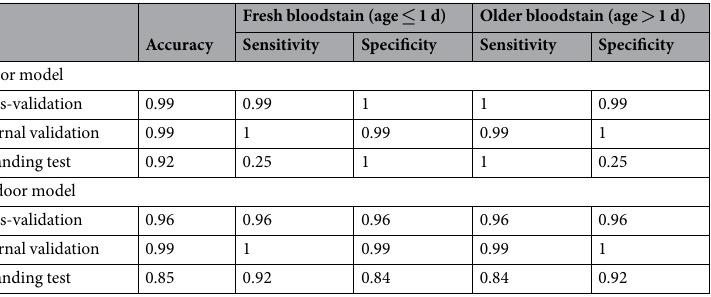
Table 4. PLS-DA classification parameters obtained in the cross-validation, external validation and expanding